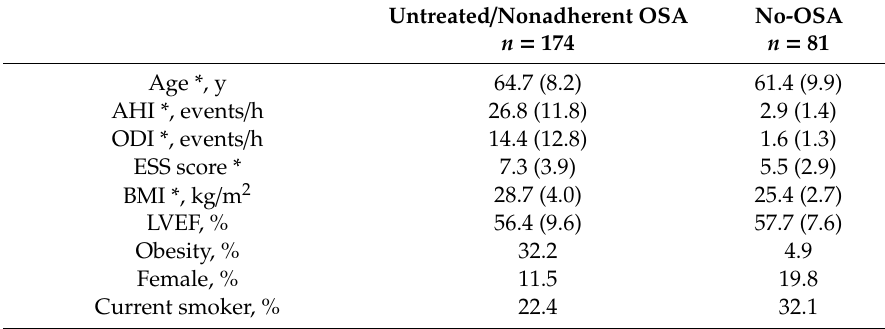
Table 4. Demographic and clinical characteristics of the ACS patients with untreated or nonadherent OSA patients versus ACS patients without OSA at